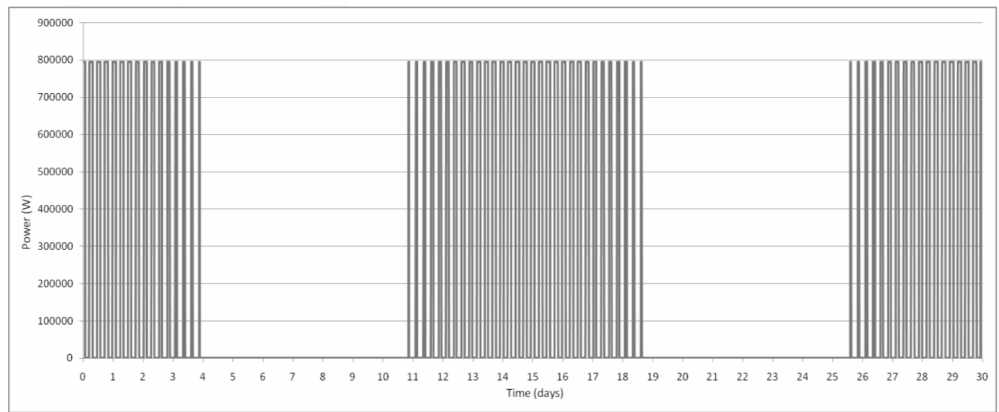
Figure 5. Intermittent power profile used for simulations.